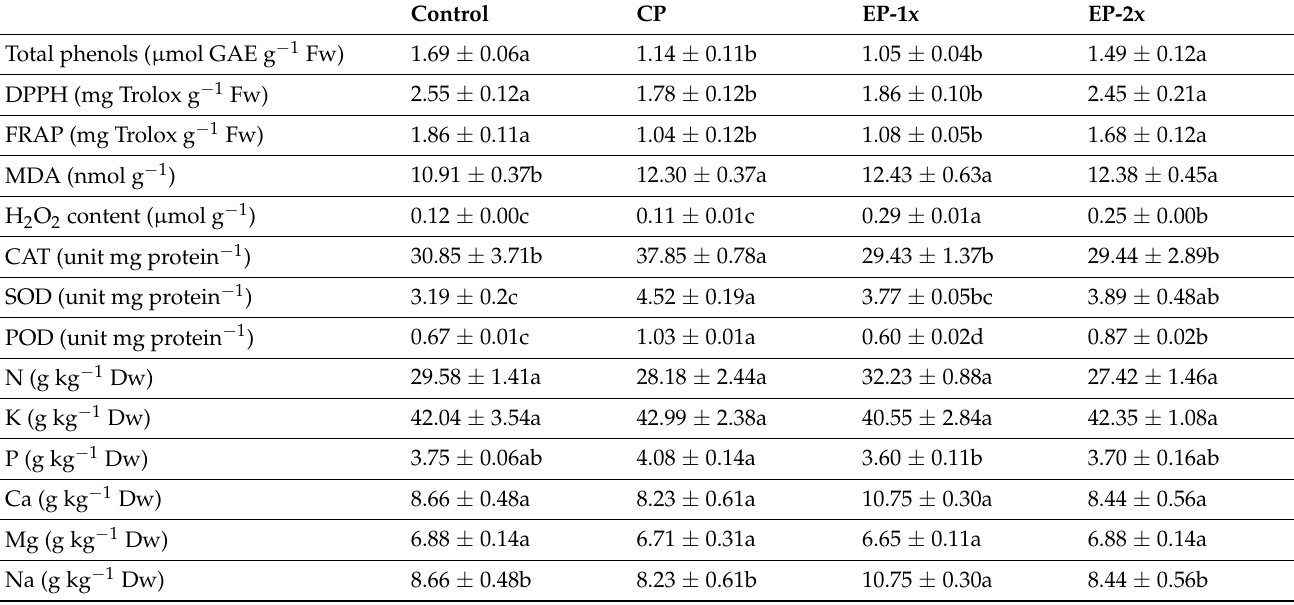
Control: indicates foliar application with water; CP: indicates the commercial product; EP: indicates the eco- product; 1x: indicates one-time application; 2x: indicates two-times applications. Means ± SE followed by different Latin letters are significantly different according to Duncan’s MRT ( p = 0.05).